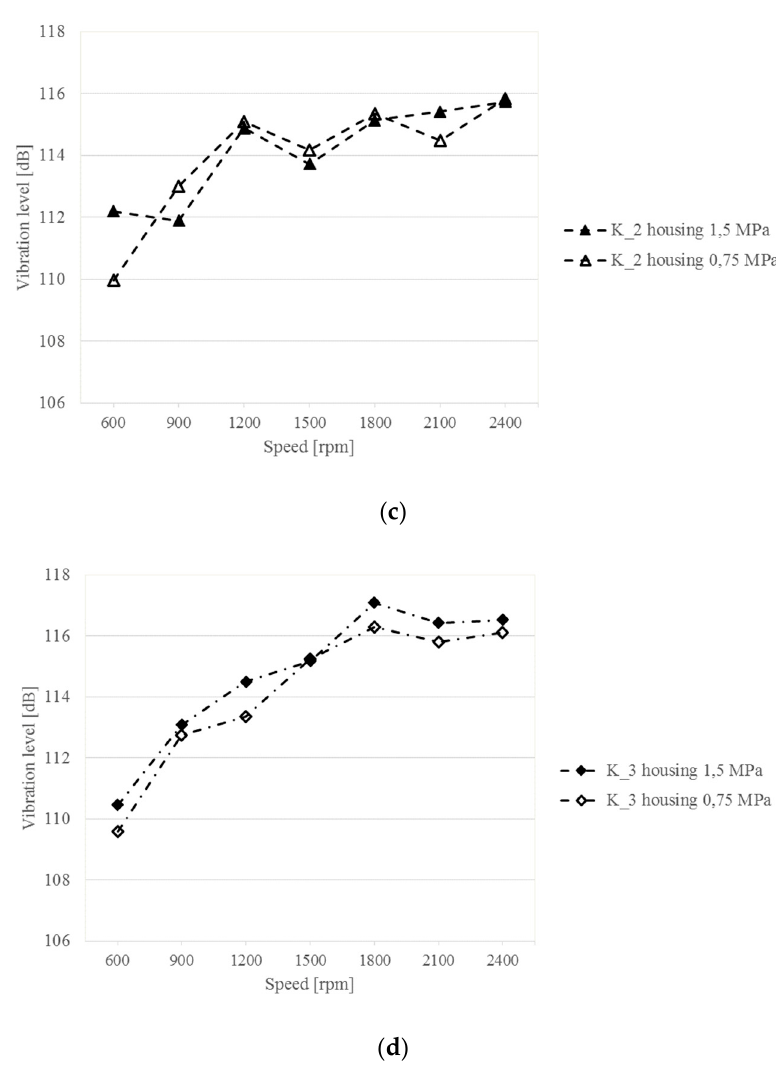
Figure 11. Changes in the vibration level of the upper gearbox plate at different rotational speeds of the gear and different loads.